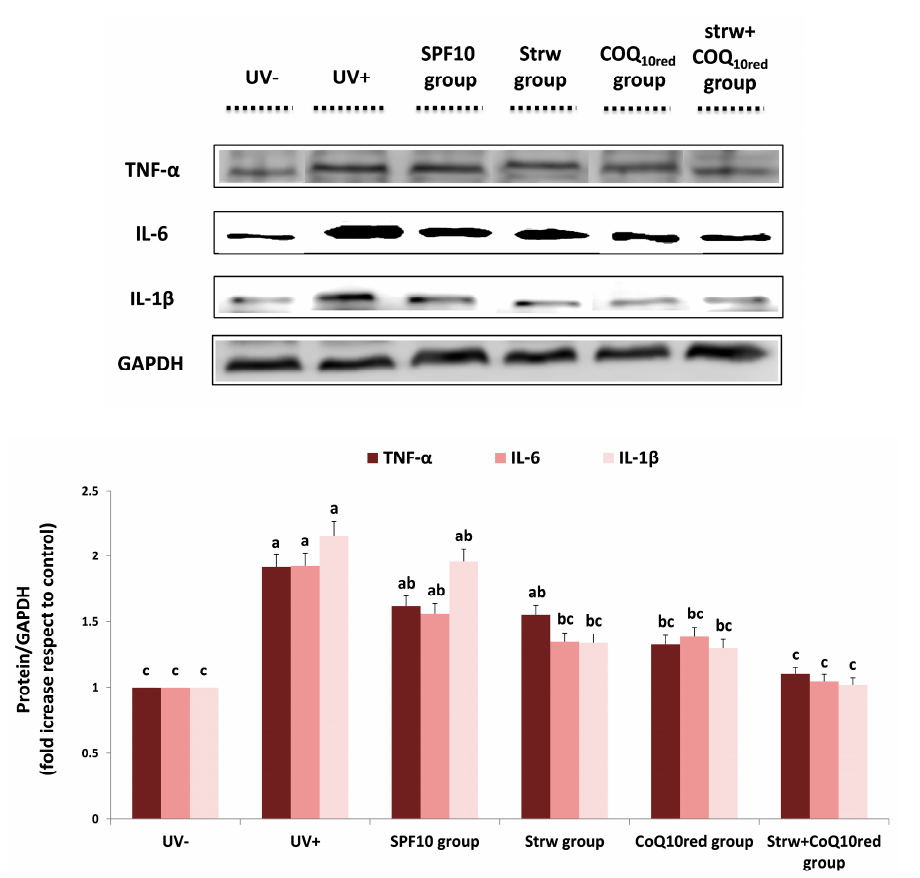
Figure 7. Levels of inflammatory markers (TNF- α , IL-1 β , IL-6) in human dermal fibroblast (HDF) cells irradiated with ultraviolet A (UVA, 275 kJ/m 2 ) radiation (UV+) or not irradiated (UV − ), after 1 h of exposure. HDF were screened with different formulations as explained in the text. Data are expressed as mean values ± standard deviation (SD). Columns belonging to the same set of data with different superscript letters are significantly different ( p < 0.05).